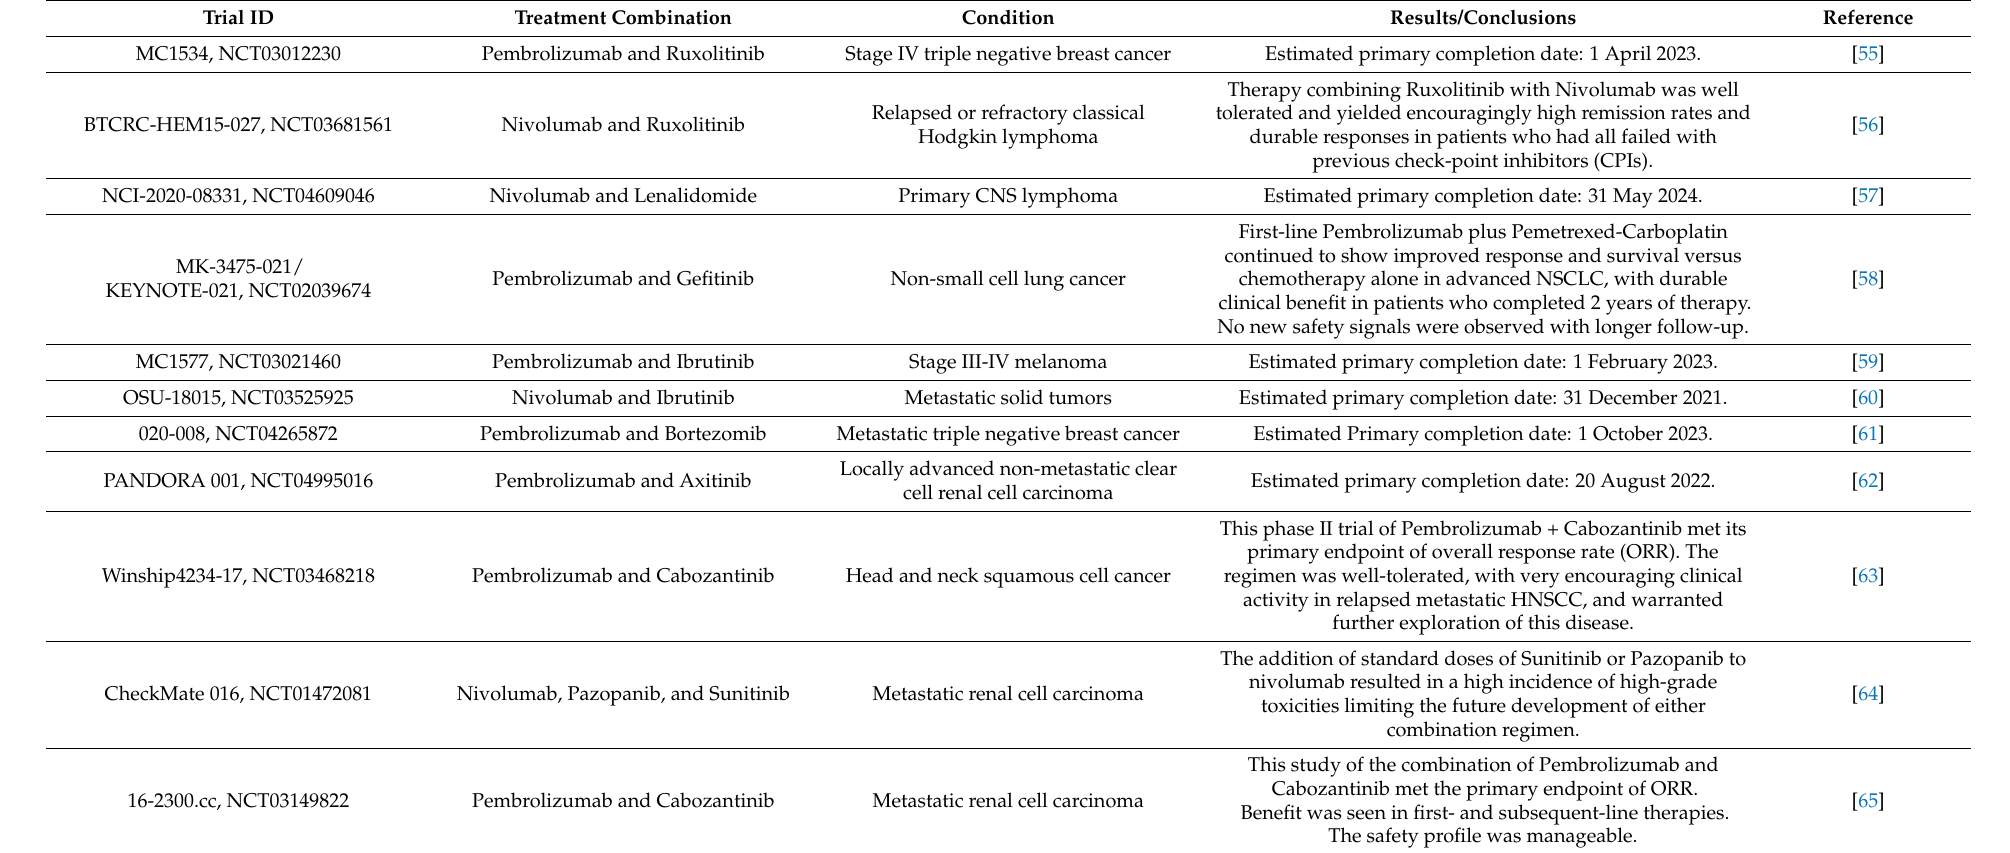
Table 4. Clinical trials for predicted immuno-targeted